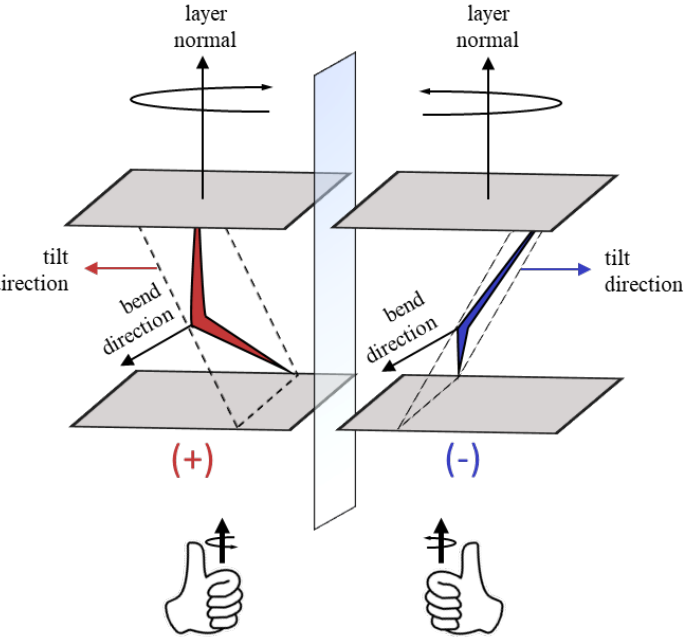
Figure 17. A sketch showing layer chirality in a tilted phase consisting of bent molecules.